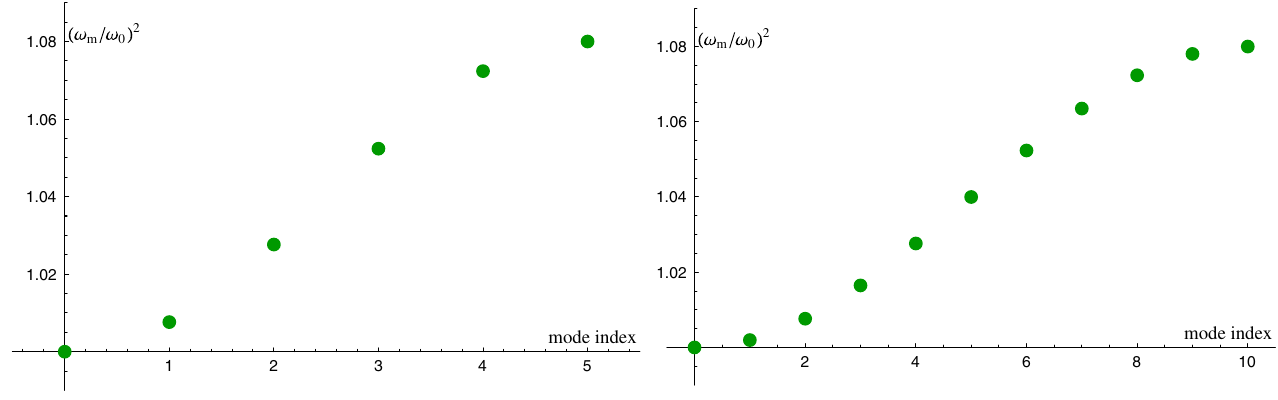
FIG. 14. (Color) Relative mode frequency (squares); left: five-cell, right: ten-cell.